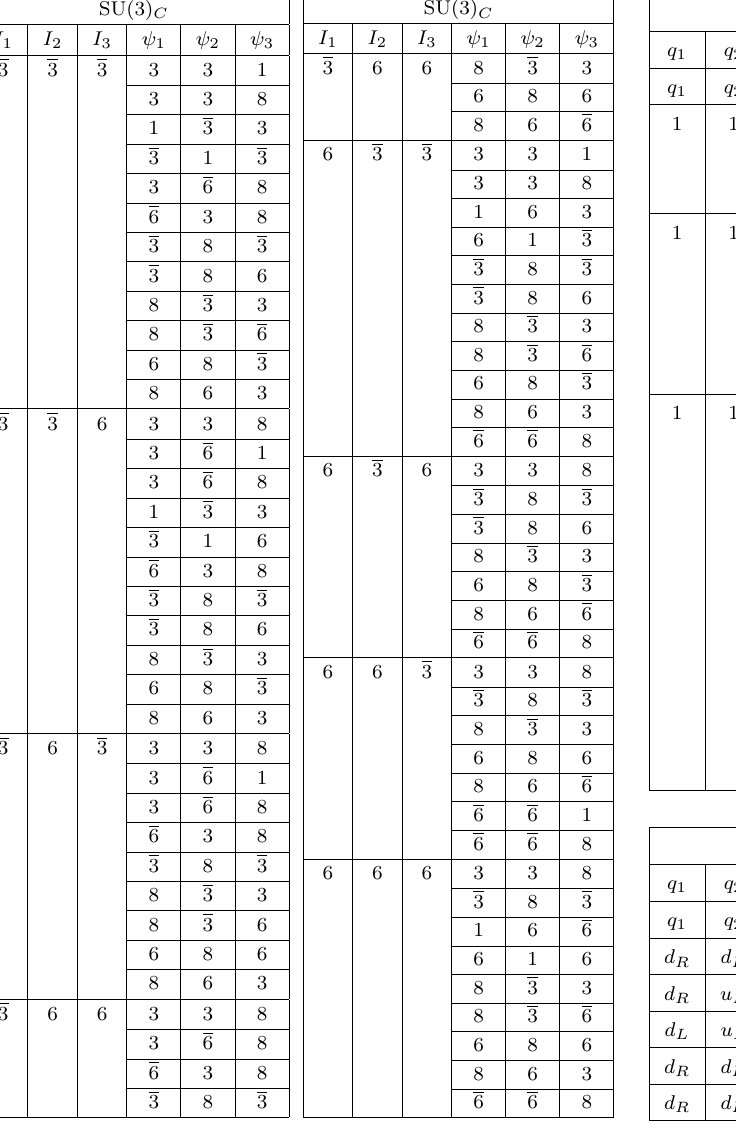
Table 15 . The possible quantum numbers of the fields in Topology-L-9 and